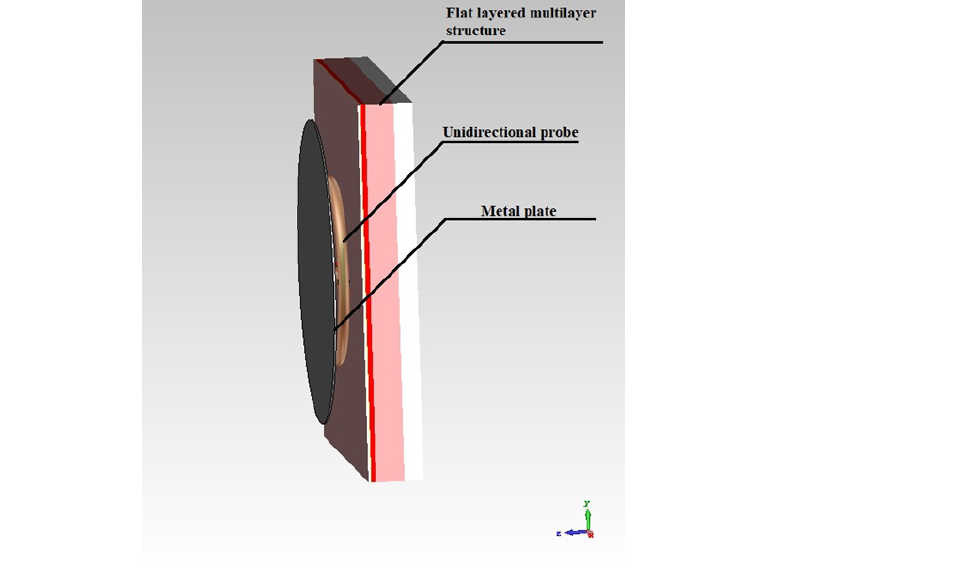
Figure 5. Model of numerical experiments with a flat layered biological medium and a unidirec- tional probe.